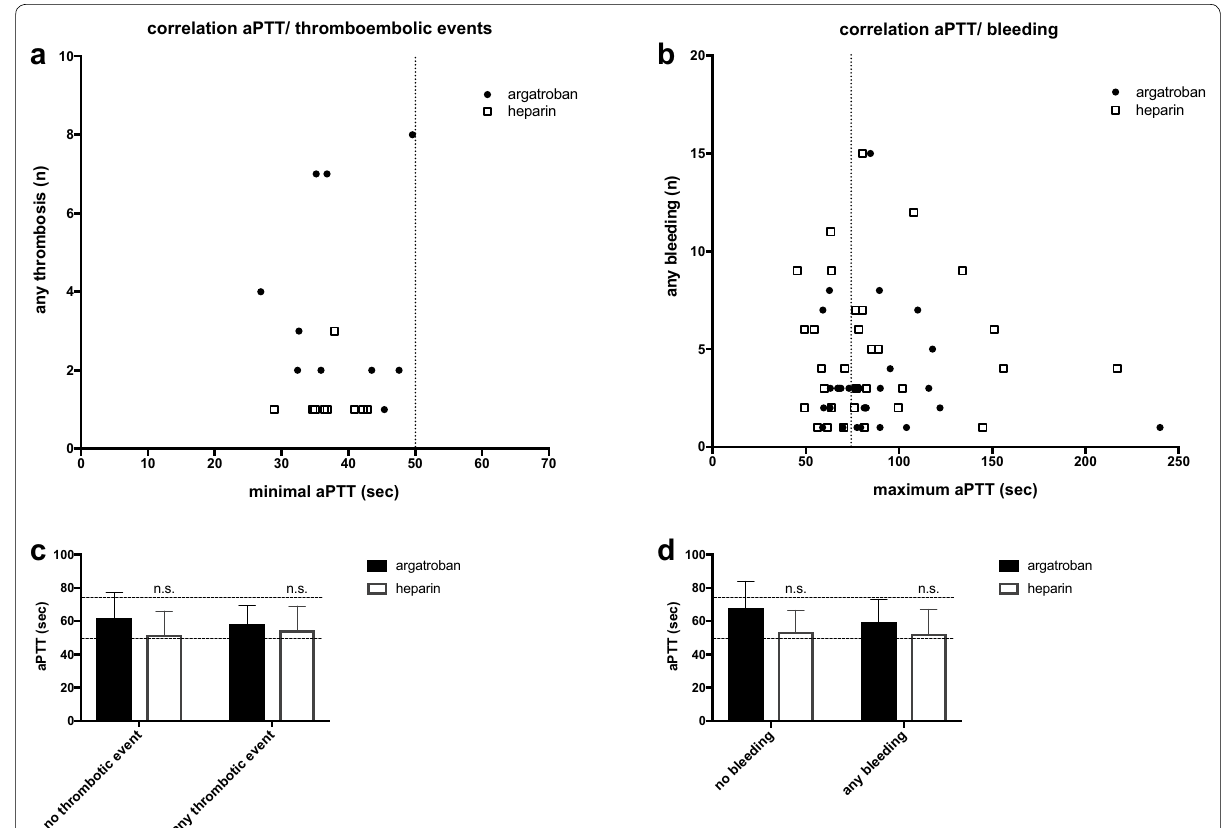
Fig. 4 a Correlation of any thromboembolic event ( n ) and the minimal aPTT value ( s ) and b correlation of any bleeding event ( n ) and the maximal aPTT value ( s ) in ARDS patients undergoing extracorporeal lung support with either argatroban or heparin as anticoagulant ( solid circle troban; open square heparin). Data are presented as scattered plot; each dot represents a patient with anticoagulation and the associated number = of thromboembolic episodes or bleeding events, respectively. Vertical dotted lines represent the targeted aPTT corridor of 50–75 s. c , d Comparison of mean aPTT values of ARDS patients undergoing extracorporeal lung support with either argatroban or heparin as anticoagulant with or without thromboembolic events ( c ) and with or without any bleeding episode ( d ). Data are presented as mean were analyzed with a Mann–Whitney U test for nonparametric samples. n.s. no significant differences between argatroban and heparin group; n number; APTT activated thromboplastin time; s